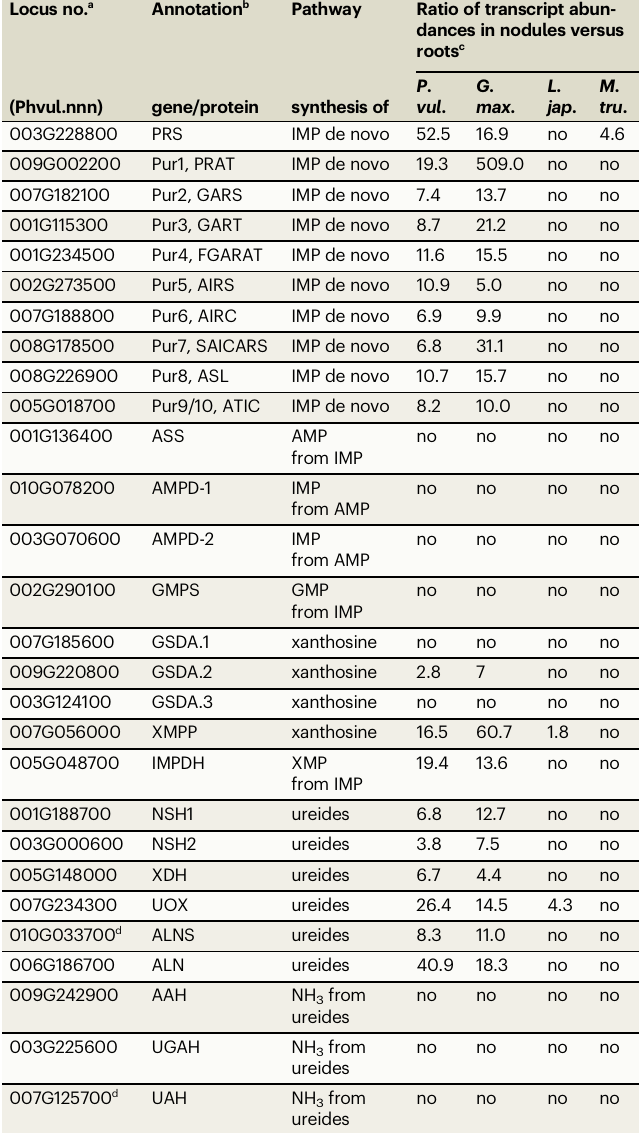
Table 1 | Ratios of transcript abundances in nodules versus roots in ureide- and amide-exporting legumes for genes of purine nucleotide and ureide biosynthesis Locus no.